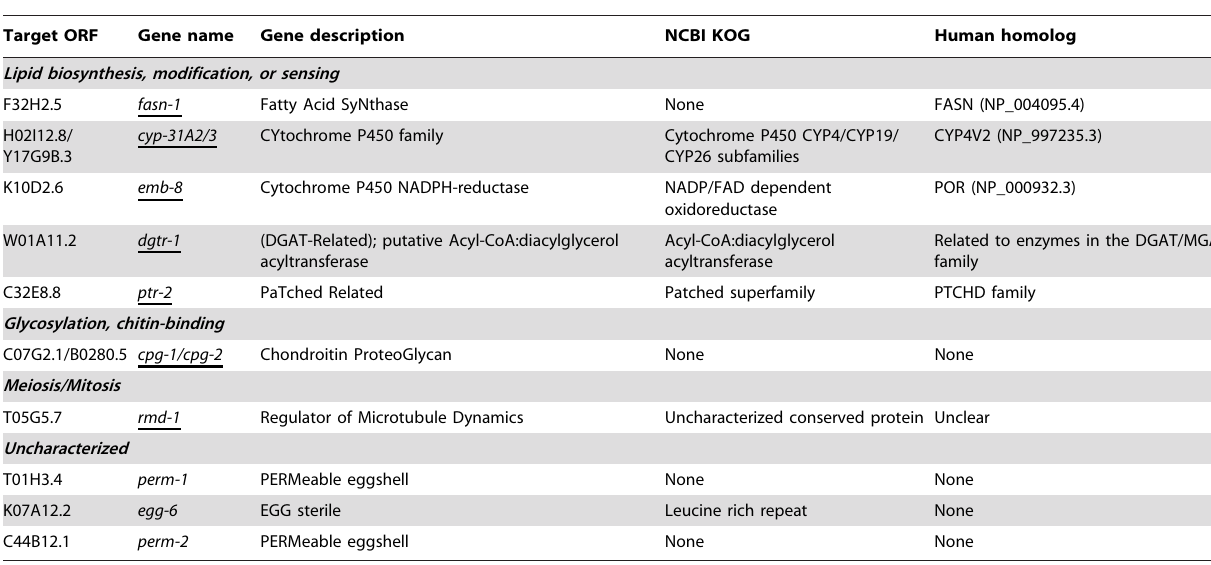
Table 1. Screen hits ( . 75% permeable embryos & brood size* . 90).